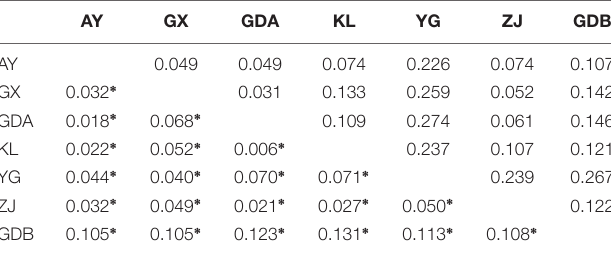
FIGURE 3 | Representation of neighbor-joining Nei’s (1972) standard genetic distance among the seven populations of M. rosenbergii based on 1,000 replicates (numbers in nodes are percentage bootstrap values). See Table 1 for population abbreviations. TABLE 5 | Matrix of pair-wise F ST values (below diagonal) and genetic distances (D A : above diagonal) between seven populations of M. rosenbergii